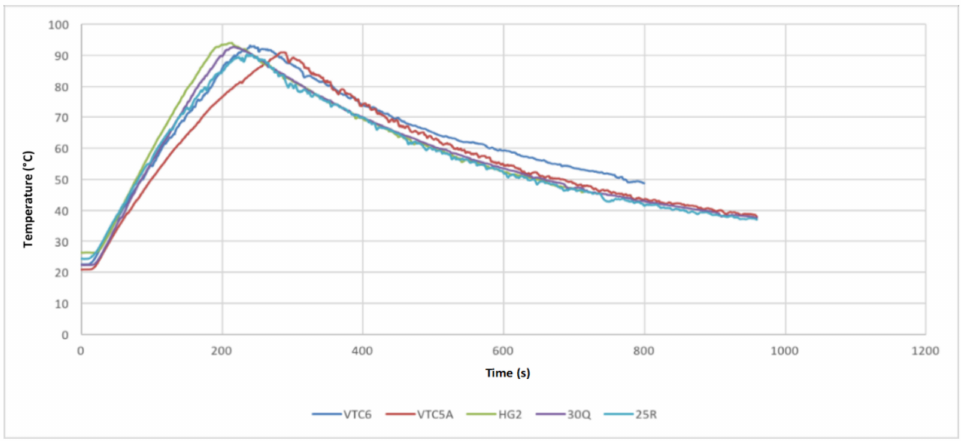
Figure 9. Single cell tests: temperatures from 15 A discharge with active air